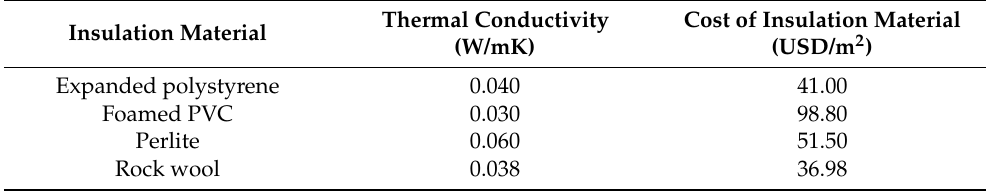
Figure 1. A photo showing the appearance of the CSG in this study. Table 1. Thermal characteristic and cost of insulating